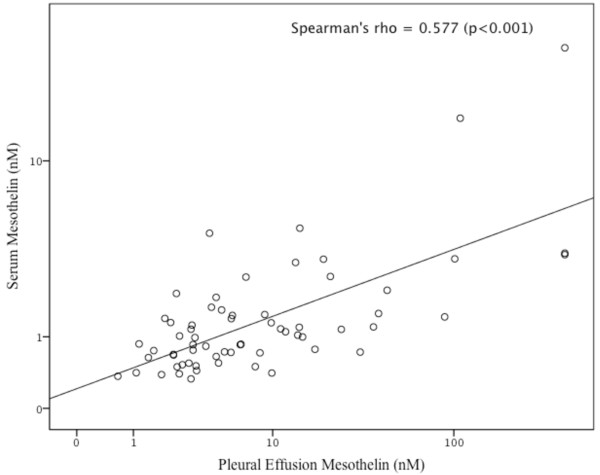
Dot plot representing the correlation of mesothelin (log values) concentration of pleural effusion and serum in study subjects (n=74).